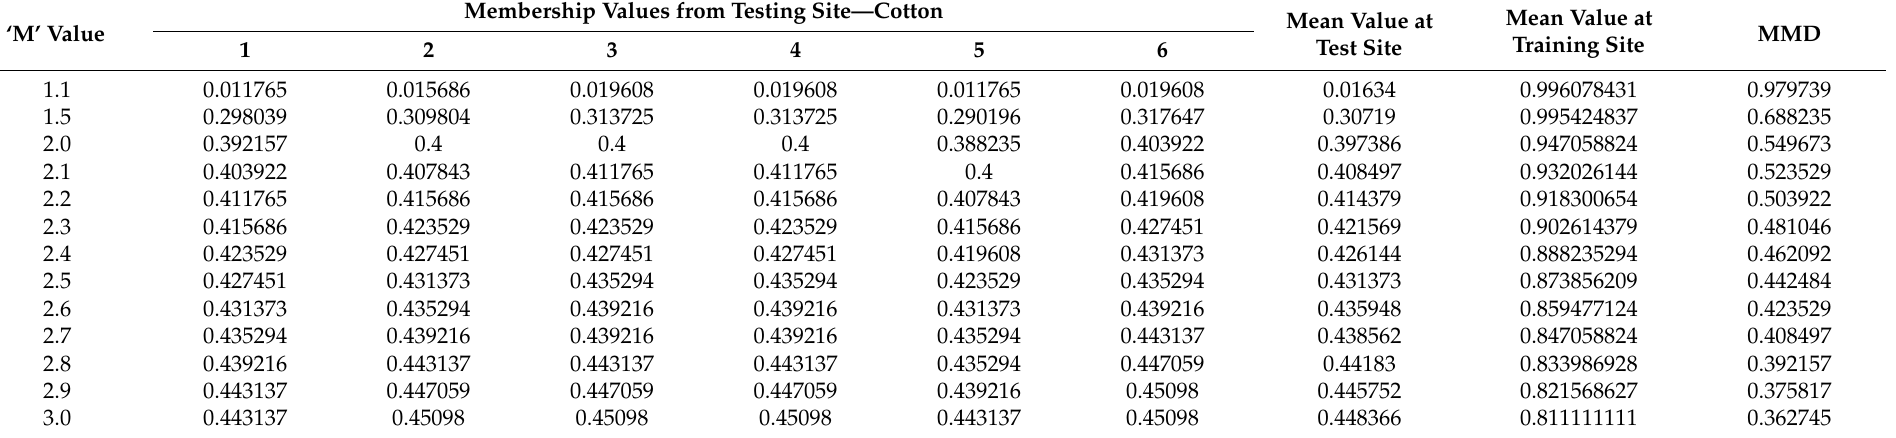
Table 7. Varying ‘m’ values with MMD exhibiting Departure of Pigeon Pea Training Fields from the Cotton Test Fields—Mean training parameter based PCM classifier.